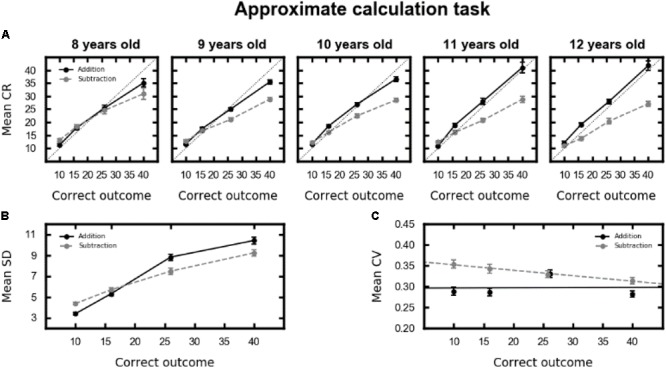
(A) Mean chosen response (CR) as a function of correct outcome (x-axis), operation (addition in black, subtraction in gray), and age (columns). The black dotted lines represent perfect performance. (B) Mean standard deviation (SD) as a function of correct outcome (x-axis) and operation (addition in black, subtraction in gray), collapsed across all ages. (C) Mean coefficients of variation (CV) as a function of correct outcome (x-axis) and operation (addition in black, subtraction in gray, the lines represent the regression models), collapsed across all ages. In all plots, error bars represent the standard error of the mean.